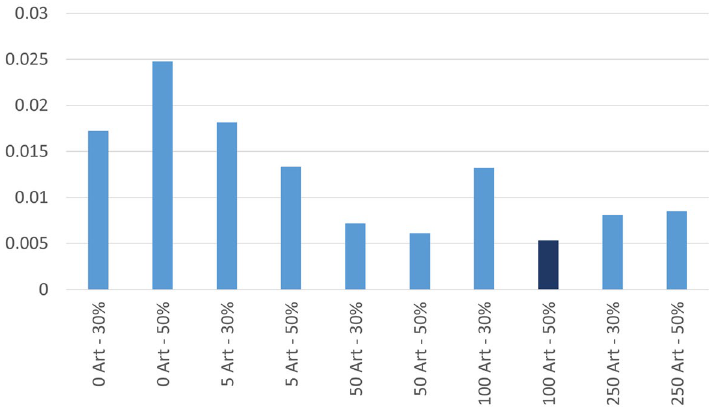
Figure 9. Difference in absolute value of the MCC and the Kappa indices. The smaller the difference, the more balanced the system will be. The best case is highlighted in dark blue.